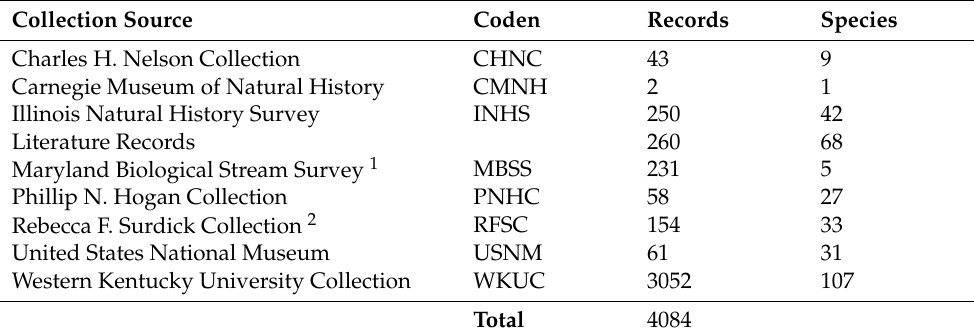
Table 1. Sources of Maryland stonefly collection records with institution name or collector, coden, and number of records and species represented from each source.